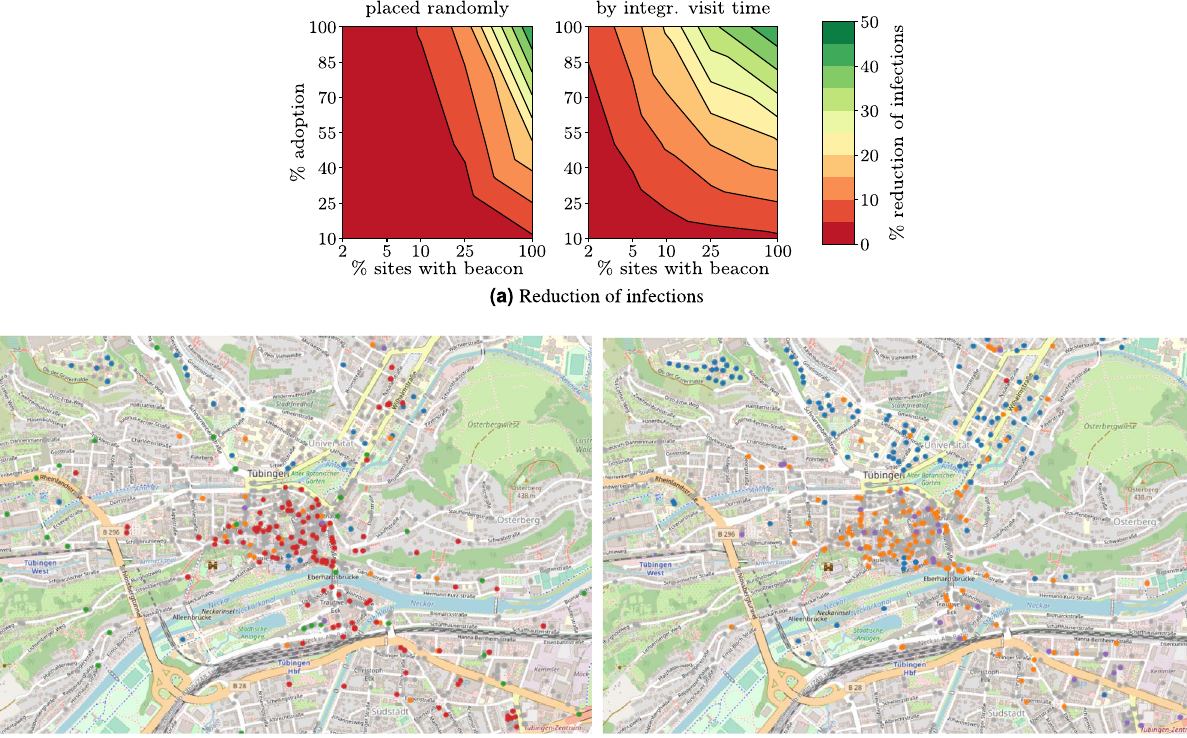
Figure 4. Beacon placement strategies. ( a ) Reduction of the number of infections under random and strategic allocation of beacons respectively over the proportion of beacons and the adoption level of PanCast (results averaged over 100 simulations). ( b , c ) Spatial distribution of beacons at 25% of the sites across our example city, Tübingen. Colored circles mark sites equipped with beacons and grey circles represent sites without beacons. The site types in our model are shops and workplaces (red), cafes, bars and restaurants (orange), schools and universities (blue), grocery stores (purple) and public transport stops (green). The maps are generated with OpenStreetMap 32 ( © OpenStreetMap